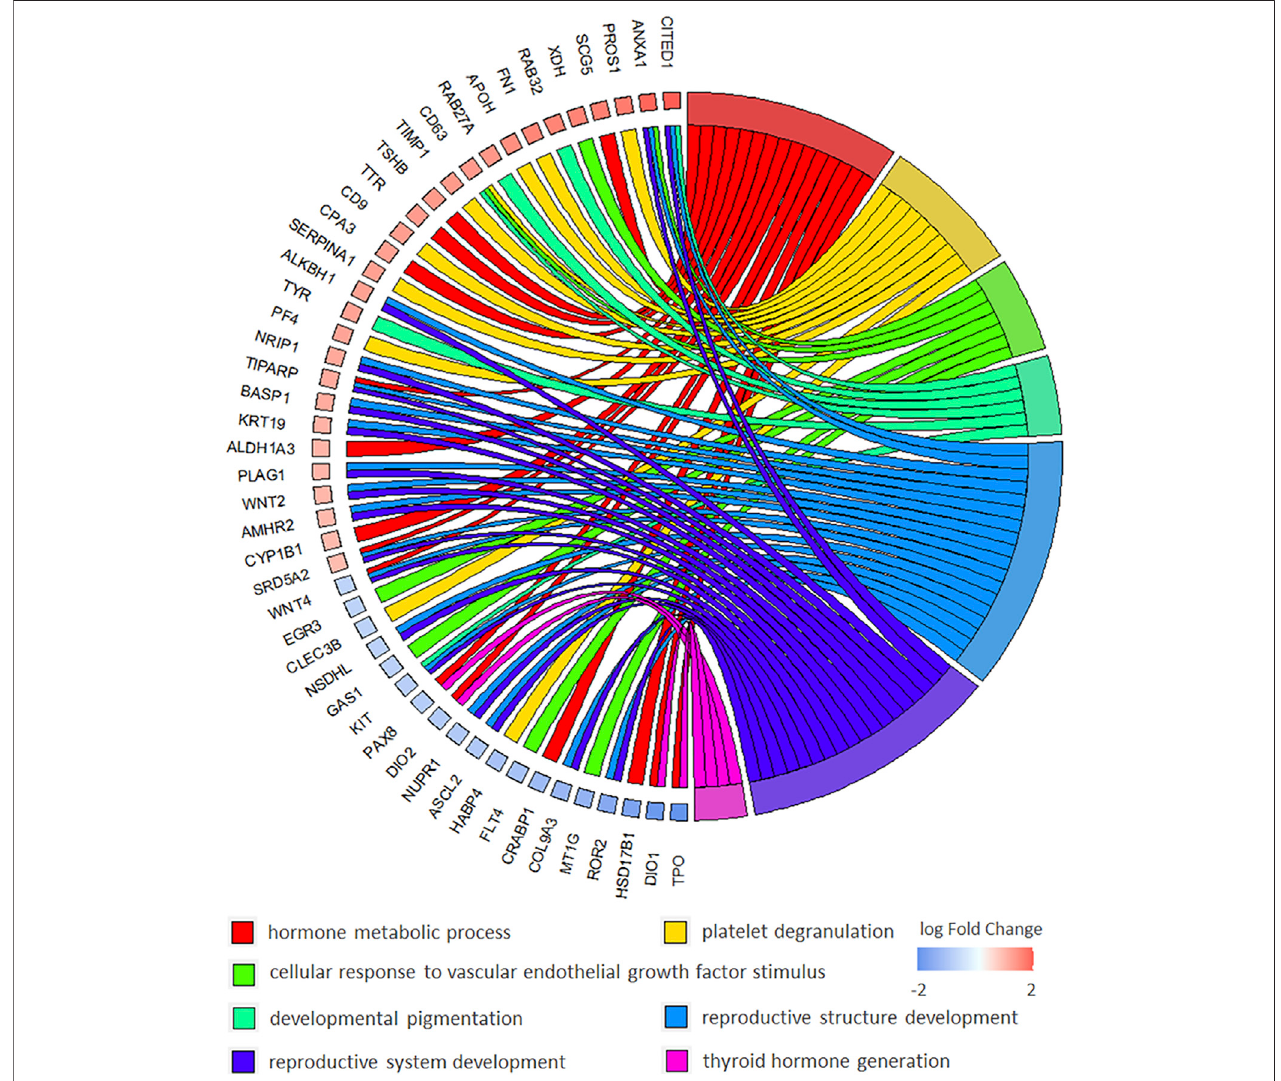
FIGURE2| ChorddiagramofBP(biologicalprocess)ofGOenrichmenttoexplaintherelationshipbetweenBPtermsandDEGsinmalignant versus benignthyroid nodules.